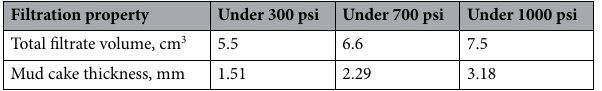
Table 3. Filtration properties with the overbalance